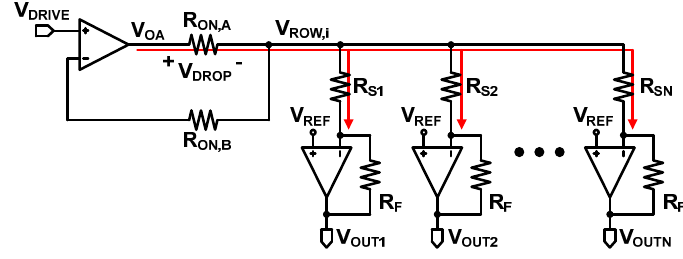
Figure 9. Equivalent circuit model of a resistive sensor array with the proposed Type III row driver.